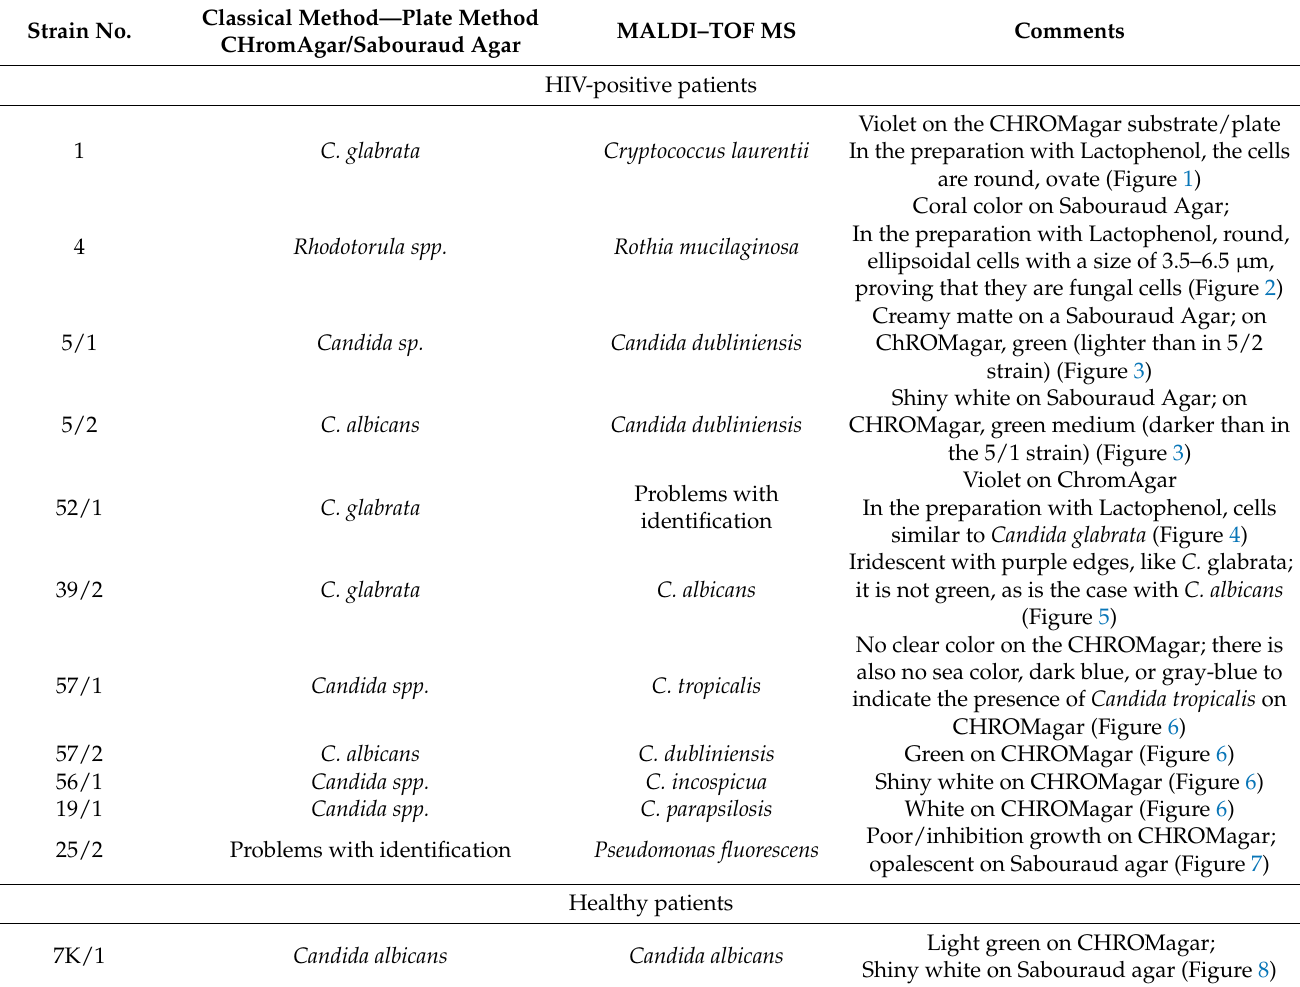
Table 3. Comparison of identification results between selected strains from study and control group—differences in strain identification by the two methods. Strain